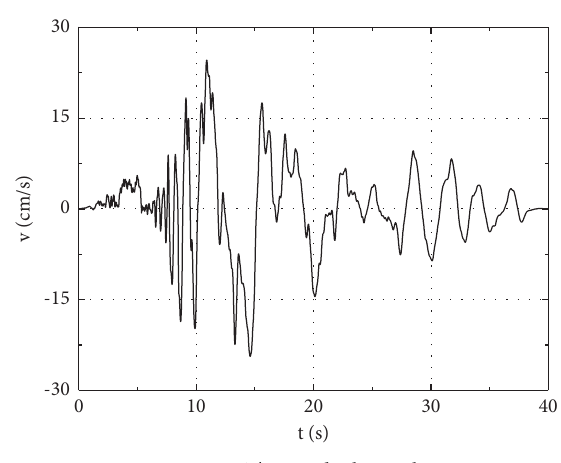
Figure 9: The residual